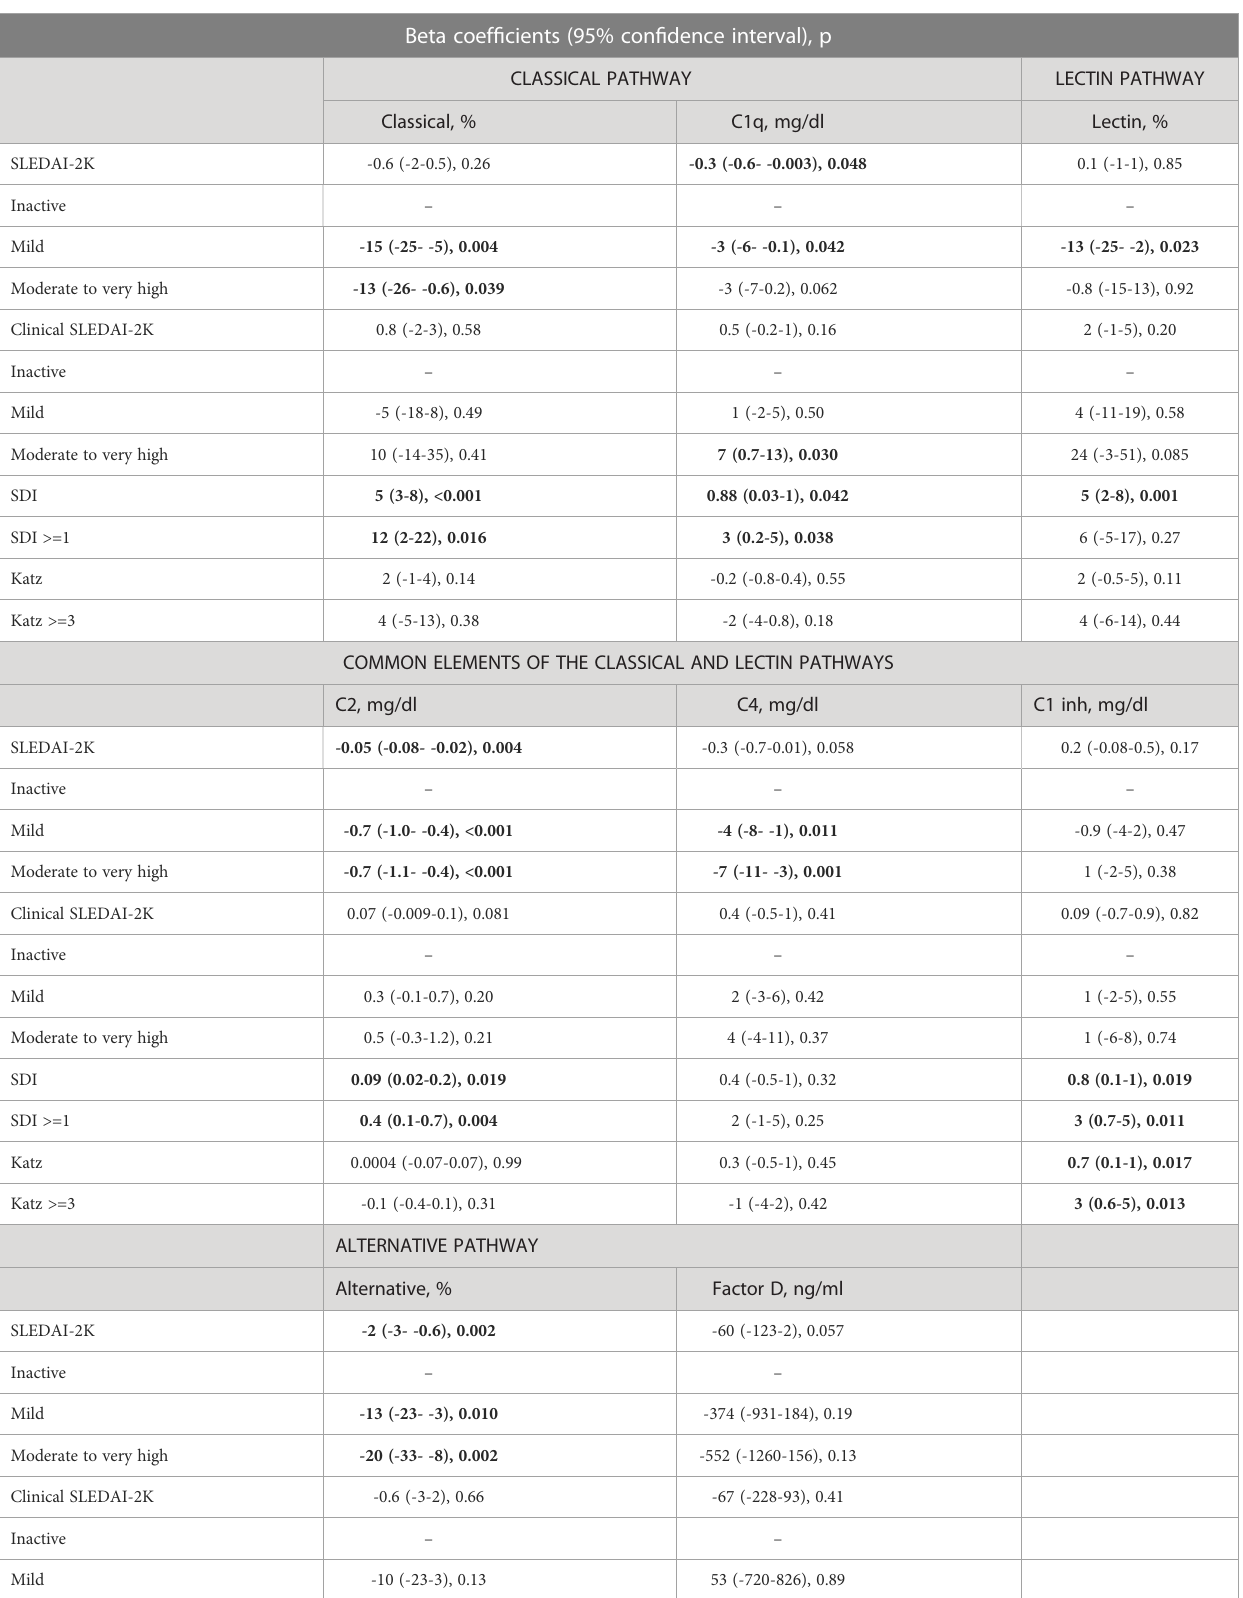
TABLE 2 Complement pathways activity and individual components relation to activity, damage and severity